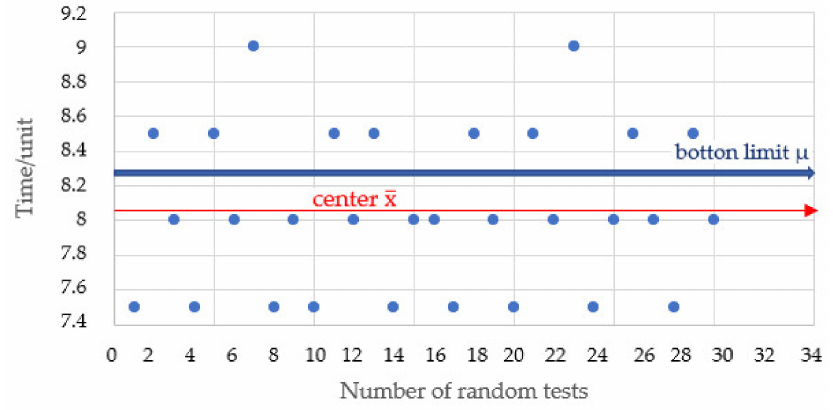
Figure 6. Graphic illustration of iron work performances, including the mean